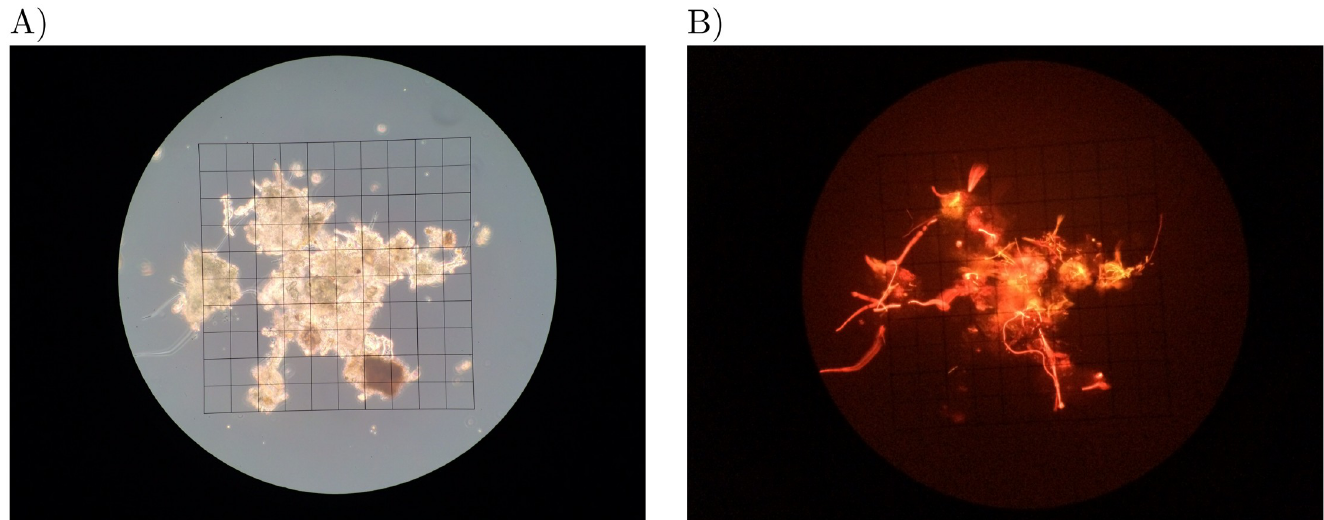
Fig 3. Microscopy of biomat samples. A) Biomat sample under 200x light microscopy magnification (grid side length = 635 μ m). B) Fluorescence microscopy at 552 nm of biomat’s Cyanobacteria.